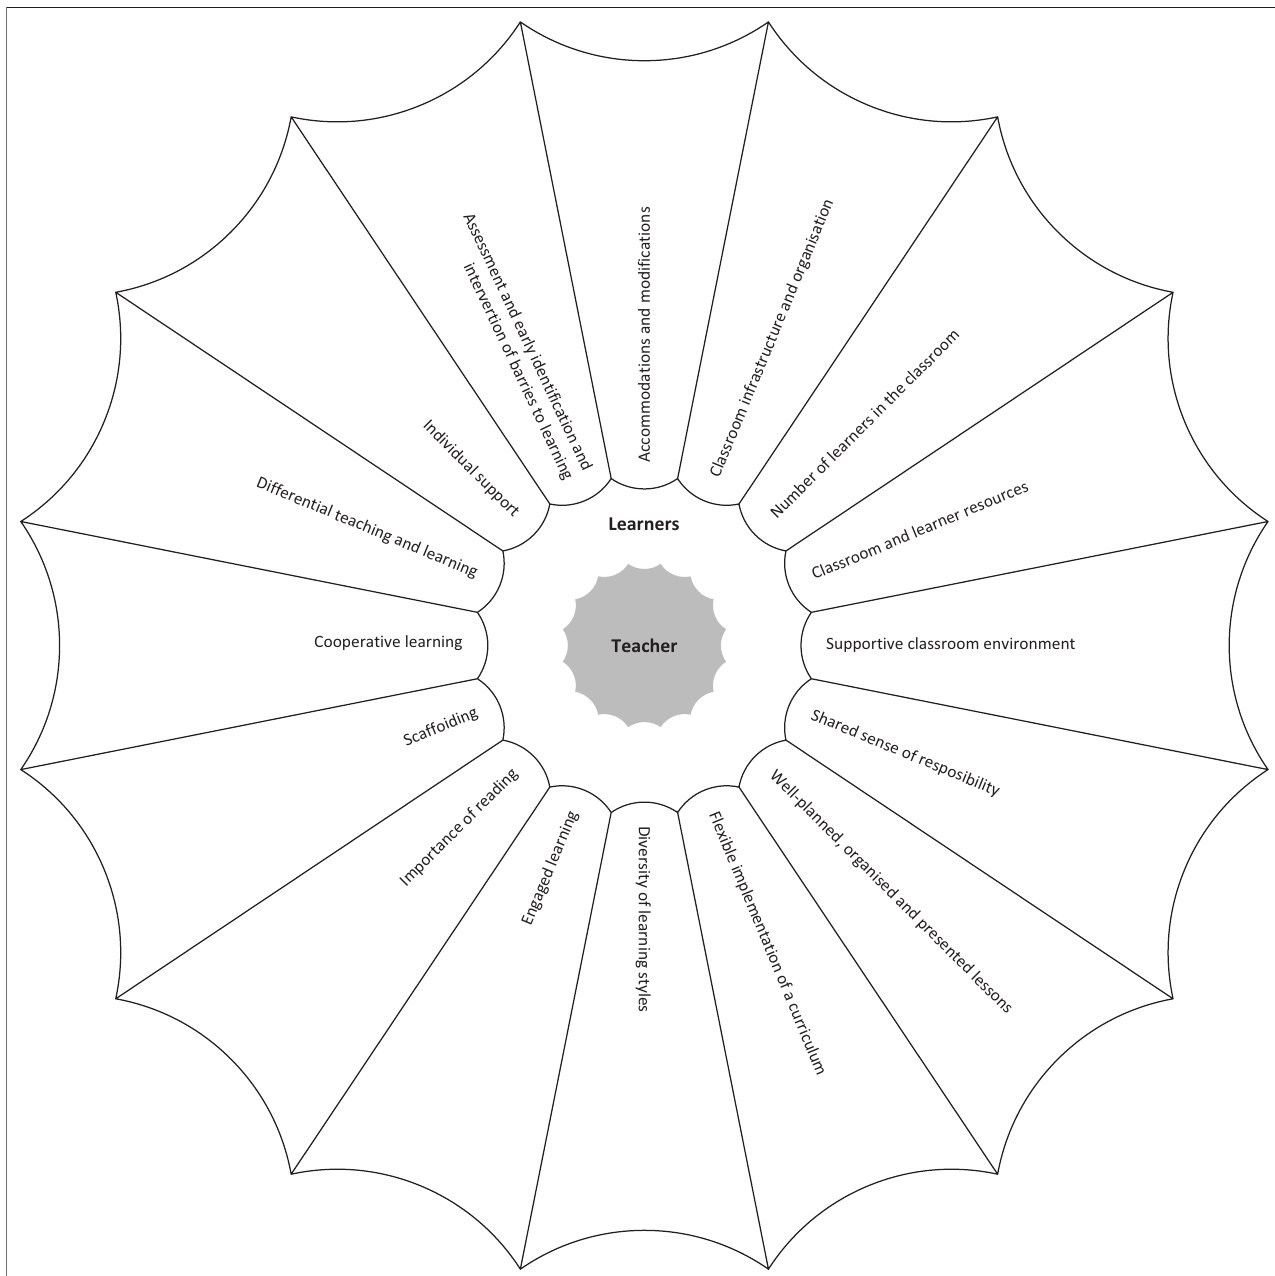
FIGURE 1: Micro-level web: The inclusive